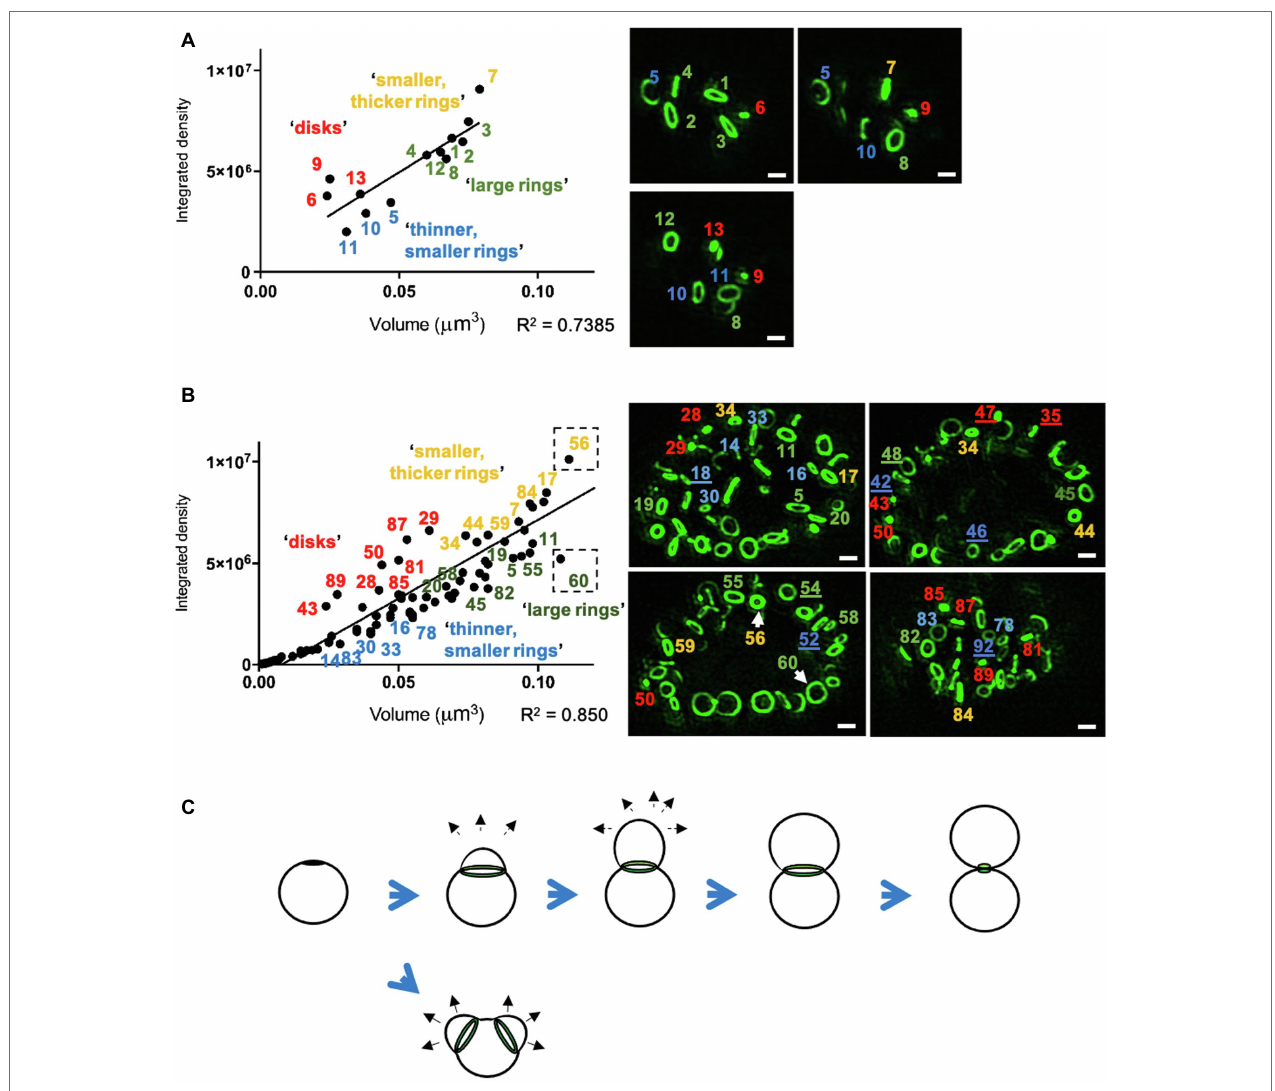
FIGURE 2 | PG ring volume and labeling intensities differ between RBs at distinct stages of the chlamydial division process. (A,B) Representative inclusion analysis of all PG-labeled objects within small ( A , < 5 μ m) and large ( B , ≥ 5 μ m) chlamydial inclusions. Picture panels (right panels, green) represent single imaging planes from two of the 100 independently imaged and analyzed C. trachomatis inclusions that were fixed and labeled at 24 h post-infection. Image brightness has been increased uniformly across all images so that dimmer objects are more visible. The calculated volumes of the corresponding labeled objects were plotted against each object’s integrated density, which is a function of object volume and mean fluorescent intensity. Distance from the calculated linear regression indicates divergence from the average mean intensity calculated for all objects within an inclusion. PG-labeled objects are numbered, and number color corresponds to the defined group to which each object was assigned. Numerical designations of objects that could not be listed on the data plot are underlined in the image panels. Arrows indicate rings of similar volume but different diameters and labeling intensities. Scale bars ~1 μ m. (C) Illustration of the polarized division model of chlamydial cell division, which is characterized by the heightened density of MOMP labeling and subsequent polar expansion of the cell membrane (black arrows) from one or two locations (as reported by Abdelrahman et al.,